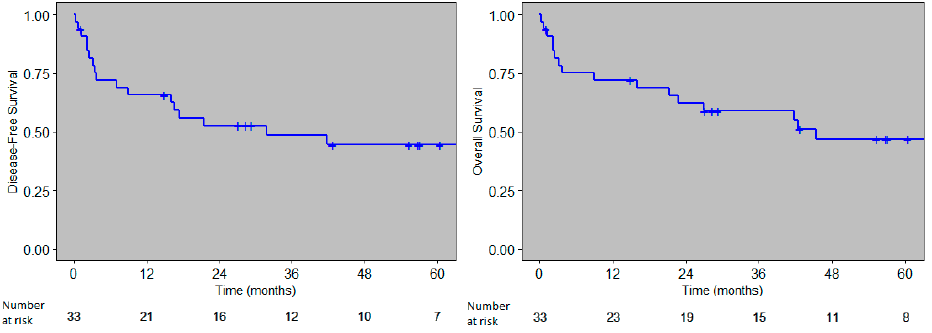
Figure 3. Disease free survival and overall survival.